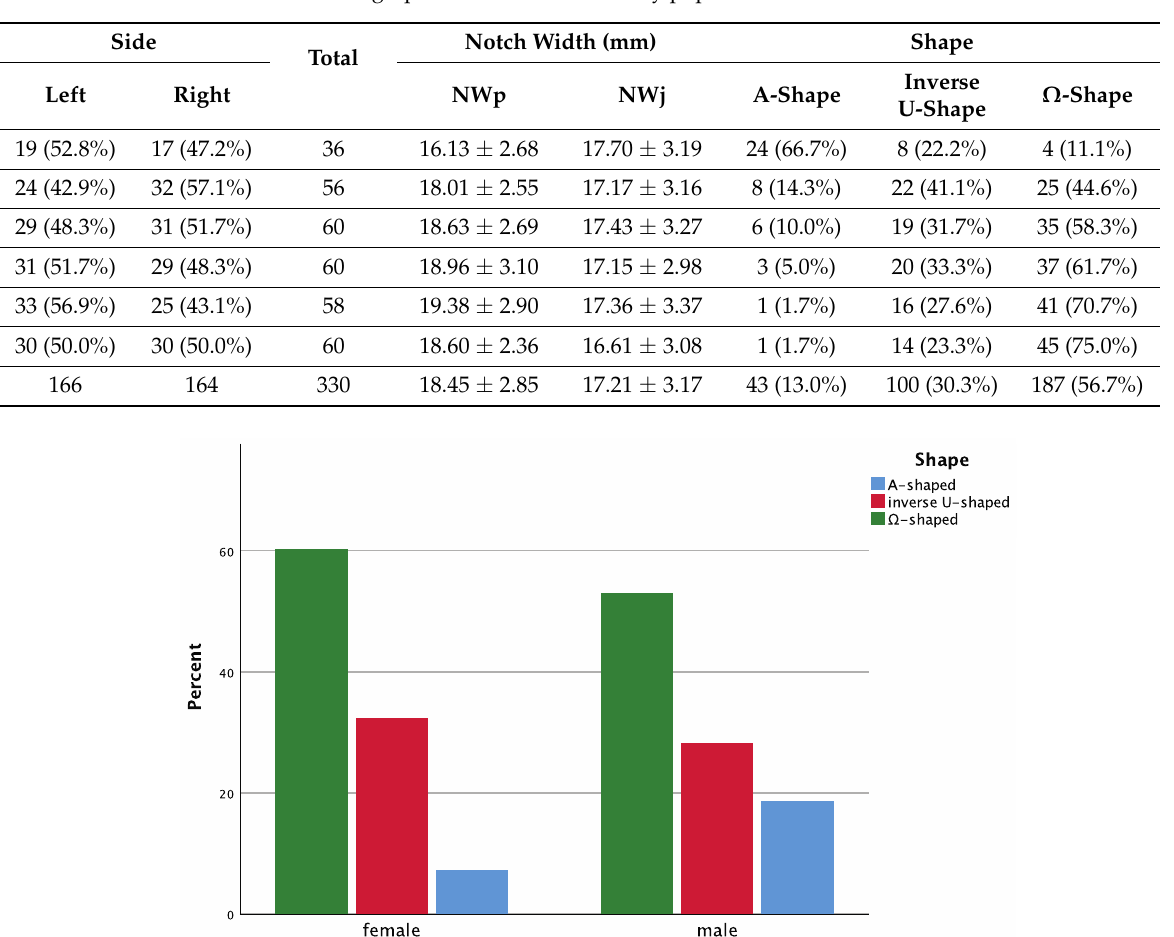
Table 1. Demographic information on study population.